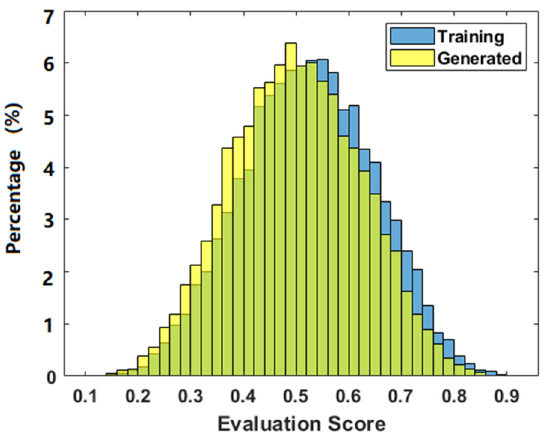
Figure 5. The distribution of the phantoms. Yellow bars represent the frequency of generated phantoms, and blue bars represent the frequency of the training phantoms.